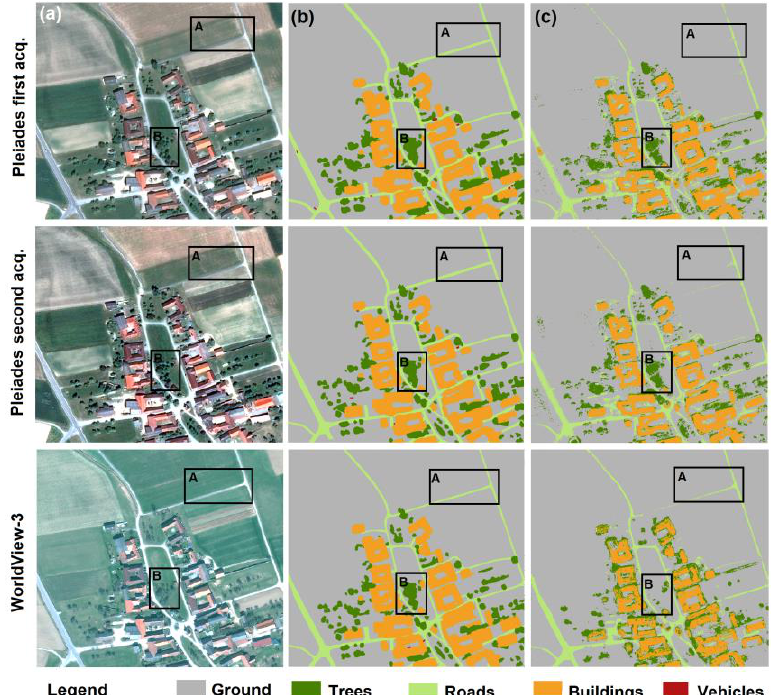
Figure 5. Top detail-view of Kleinschönau village (a) Pleiades and WorldView-3 ortho-rectified images; (b) the reference labelled 3D point cloud generated by image matching; (c) the classification